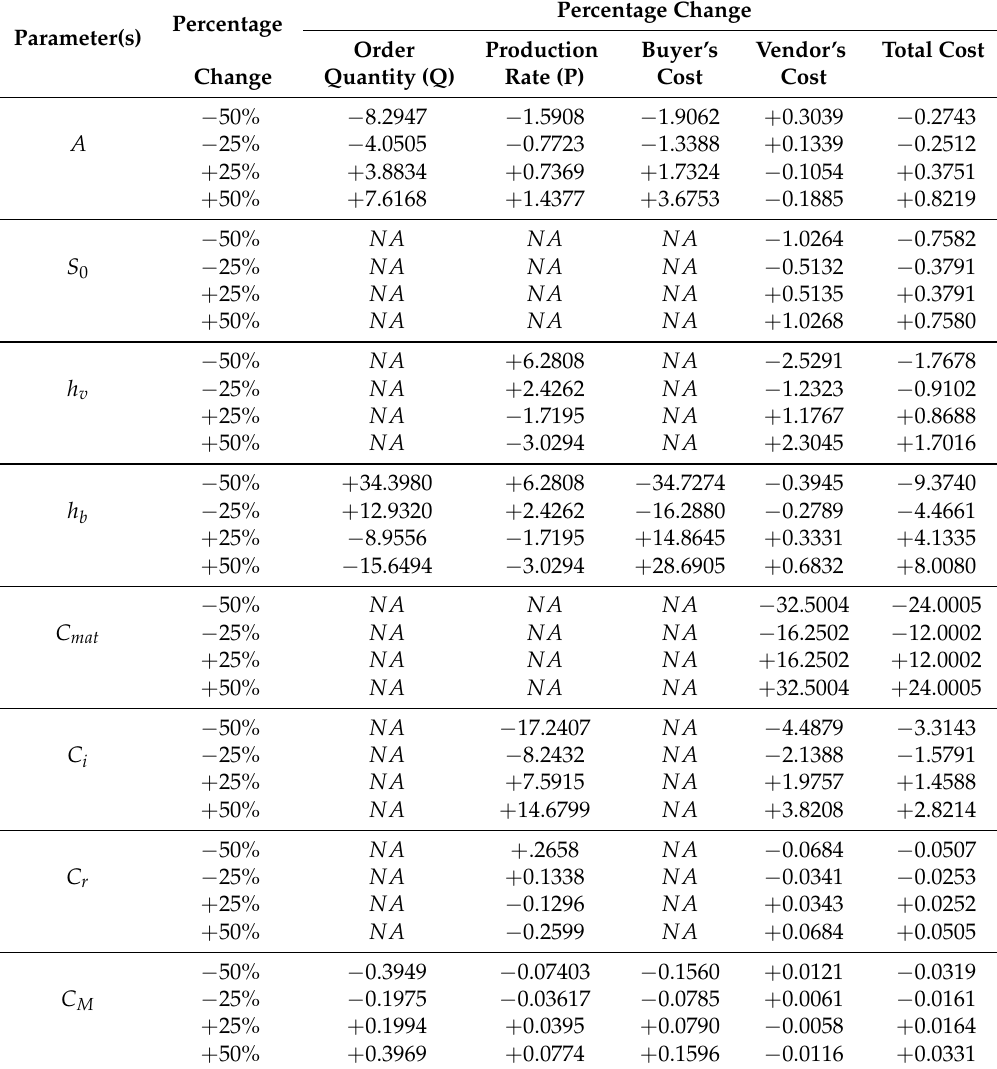
Table 6. Sensitivity analysis for decentralized model based on Stackelberg